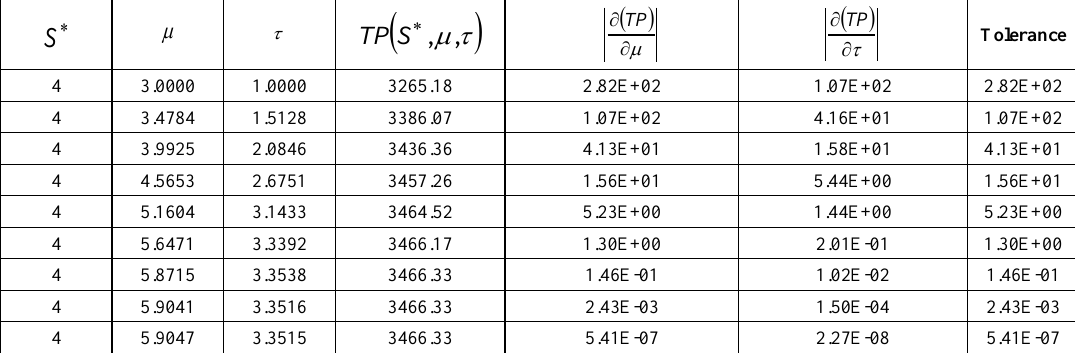
Table 10 . An illustrative example of the Newton-quasi method.